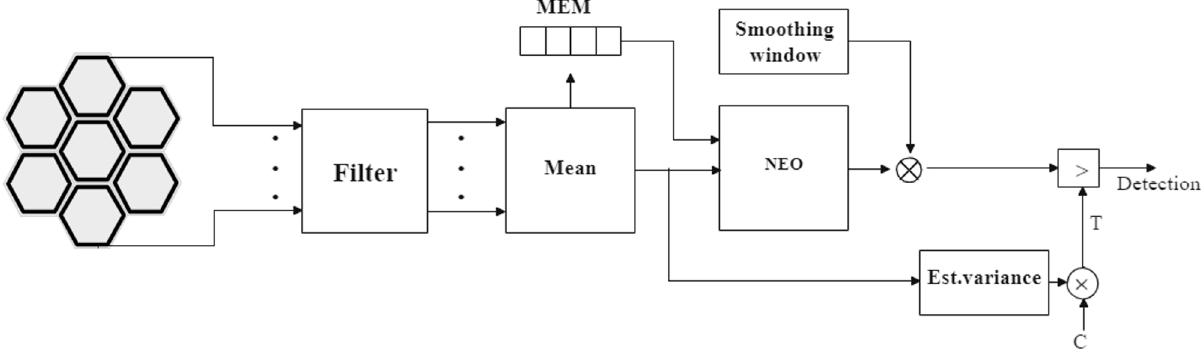
Figure 10. Post-norm block diagram. The variance estimate block takes the averaged signal as input and estimates the noise variance.